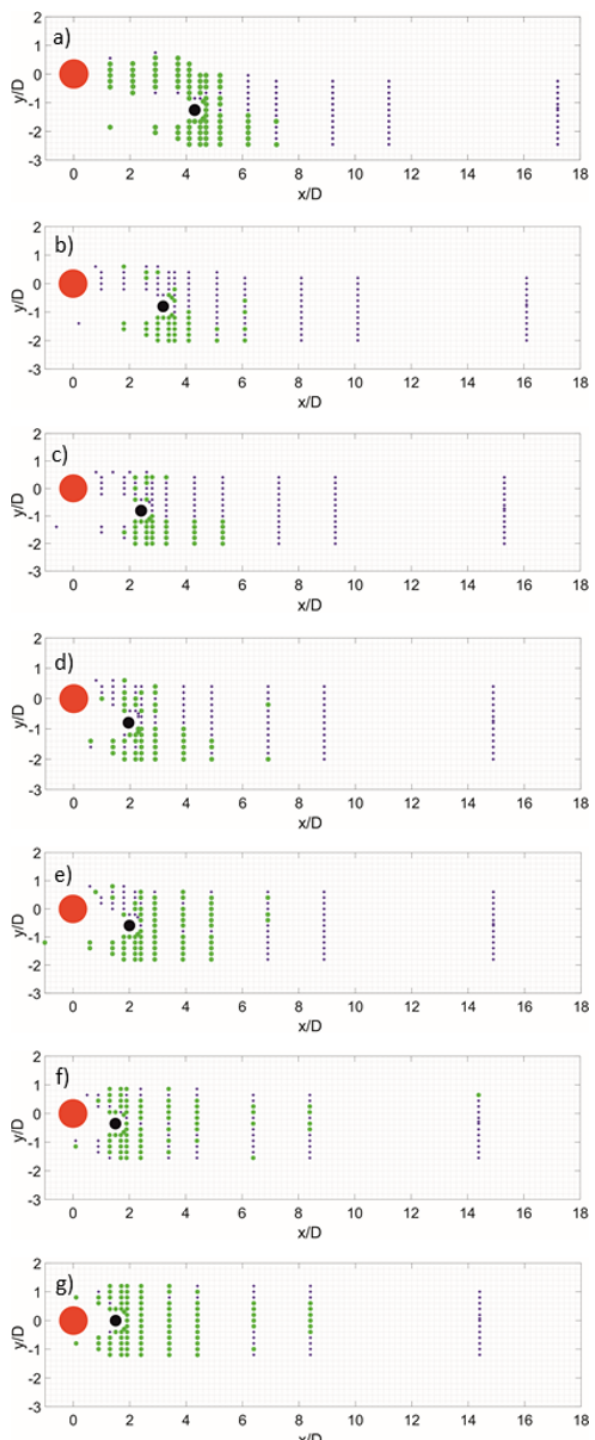
Fig. 5. Positions of hot wire probe behind the two circular cylinders, ● – positions with two strength frequencies, + - positions with only one or any frequencies, a) position 1, b) position 2, c) position 3, d) position 4, e) position 5, f)